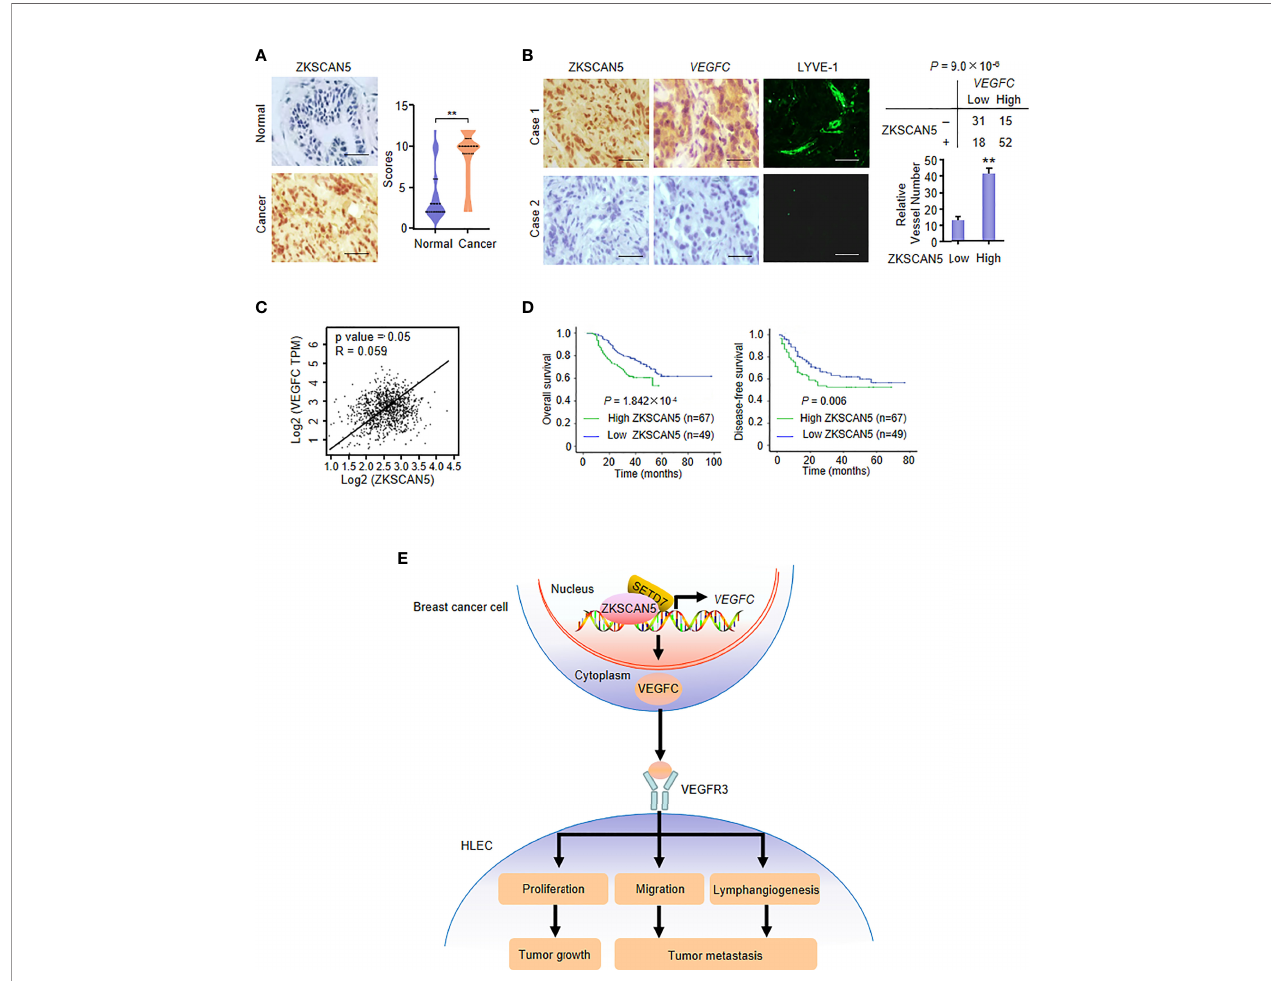
FIGURE 6 | ZKSCAN5 is a prognostic marker of breast cancer and is positively correlated with VEGFC expression. (A) Representative immunohistochemical staining of ZKSCAN5 in human cancerous breast tissues and adjacent normal breast tissues. Scale bar: 25 m m. ZKSCAN5 expression scores were plotted and compared (Mann – Whitney U test). (B) Representative immunohistochemical staining of ZKSCAN5 in human breast cancer samples. Scale bar: 25 m m. To quantify lymphatic microvessel density, images were obtained from eight regions of each tissue to calculate the number of vessels more accurately. The correlation of ZKSCAN5 with VEGFC expression or lymph microvessel number (positive LYVE-1 staining) is shown. The p value was generated using Pearson ’ s c 2 test (ZKSCAN5 and VEGFC ) and the Wilcoxon rank- sum test (LYVE-1). (C) Database analysis showed that ZKSCAN5 expression was positively correlated with VEGFC expression in breast cancer patients. (D) The total survival time (above) and disease-free survival time (below) of patients with breast cancer were estimated by the Kaplan – Meier method. The review samples are represented by the markers on the chart lines. (E) Proposed model for ZKSCAN5 modulation of VEGFC expression as well as its tumour-promoting function. ZKSCAN5 recruited SETD7 into the VEGFC promoter, which promoted the increase of VEGFC transcription and secretion in breast cancer cells. VEGFC is secreted by cancer cells, binding to VEGFR3, promoting proliferation, migration and lymphangiogenesis of HELC. Ultimately, they can lead to tumour growth and